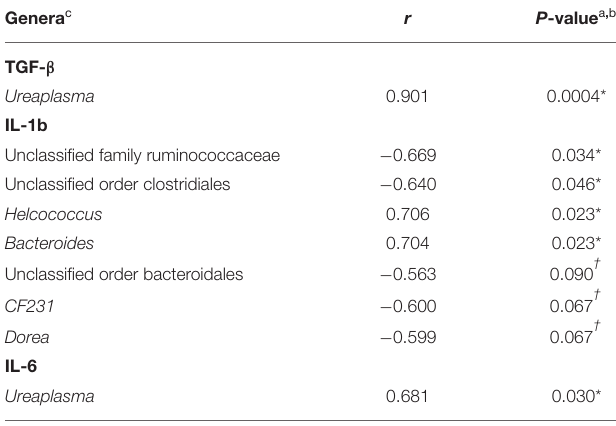
TABLE 1 | Pearson correlation coefficients ( r ) for TGF- β , IL-1b, and IL-6 and the relative abundance of genera within the uterus of resulting non-pregnant cows for d − 21.